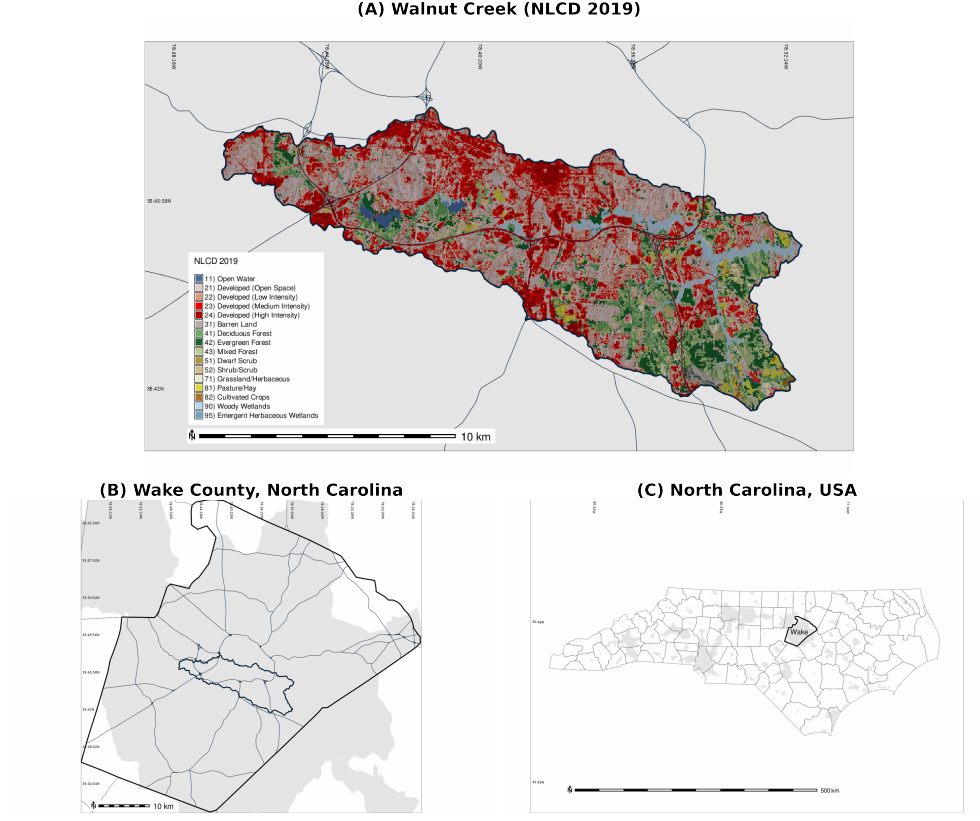
Figure 2. The study area is located in the ( A ) Walnut Creek Watershed (Neuse River Basin) of ( B ) Wake County, ( C ) North Carolina, United States of America. The most recent land cover provided by NLCD 2019 shows that the watershed is highly developed, but remains mostly forested in the south